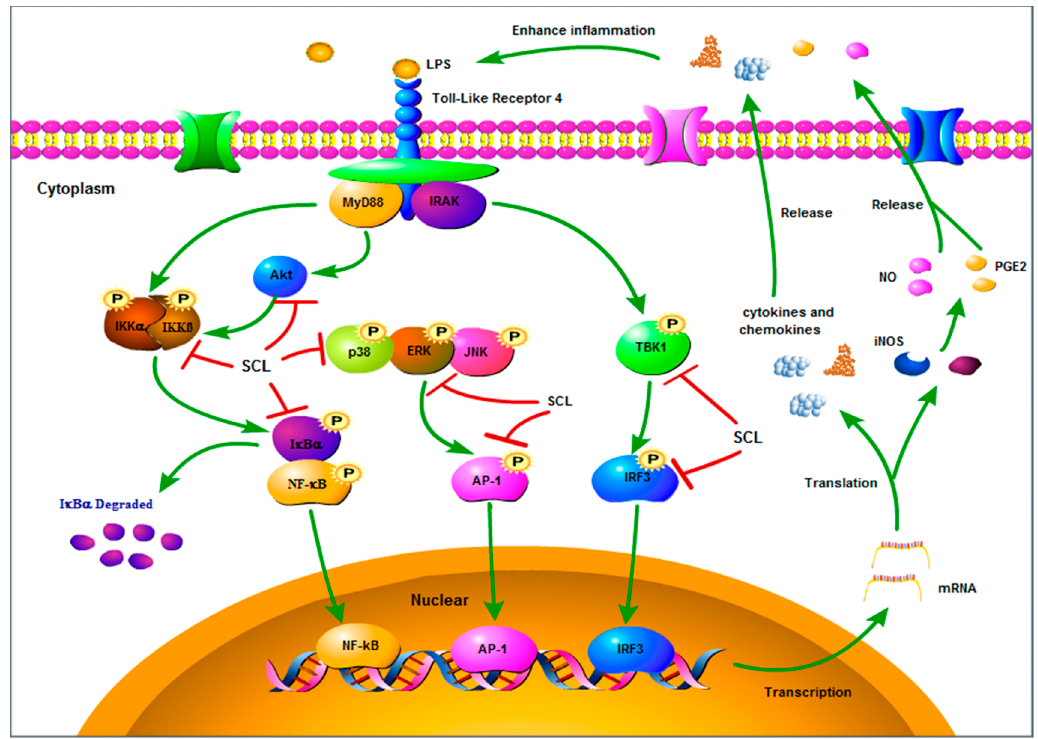
Figure 9. Proposed molecular mechanisms underlying the inhibitory effects of SCL on the production of inflammatory mediators. SCL inhibits IKK α / β /NF- κ B, MAPKs/AP-1 and TBK1/IRF3 pathways in LPS-stimulated RAW264.7 cells.